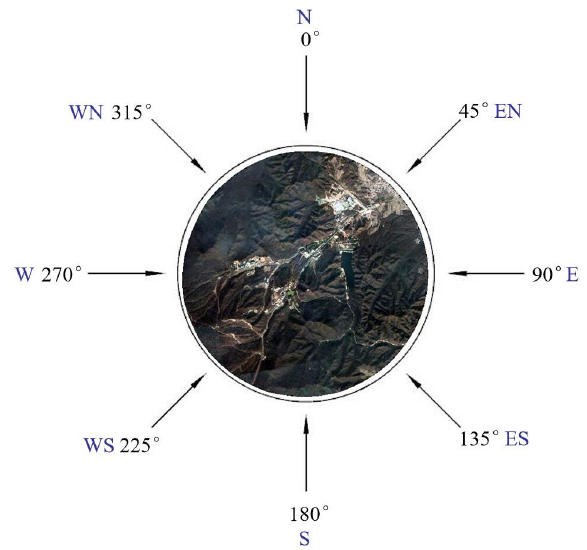
Figure 12. Wind direction cases.